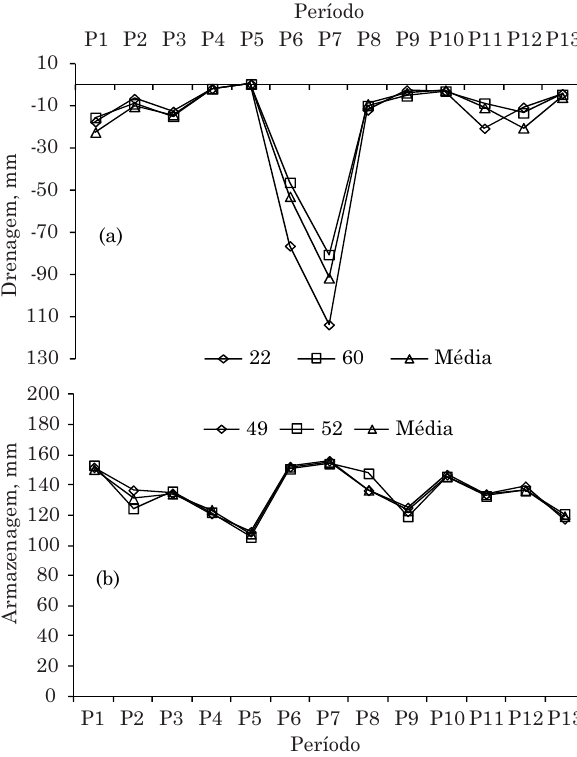
Figura 6. Distribuição do comportamento da drenagem interna (a) e da armazenagem (b) da água no solo nos pontos com estabilidade temporal durante os períodos